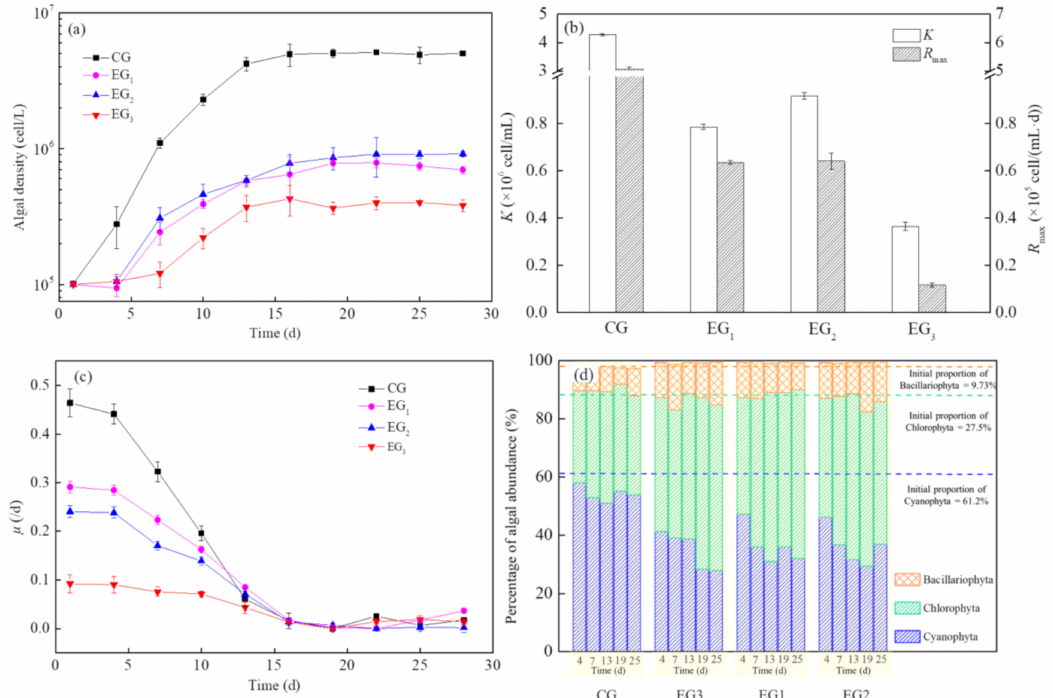
Figure 6. Changes in algal growth curves: ( a ) maximum algal biomass K , ( b ) maximum population growth rate R max and ( c ) specific growth rate, µ and ( d ) algal abundance, under single planting and combined planting treatments. Results are expressed as average ± SD ( n =